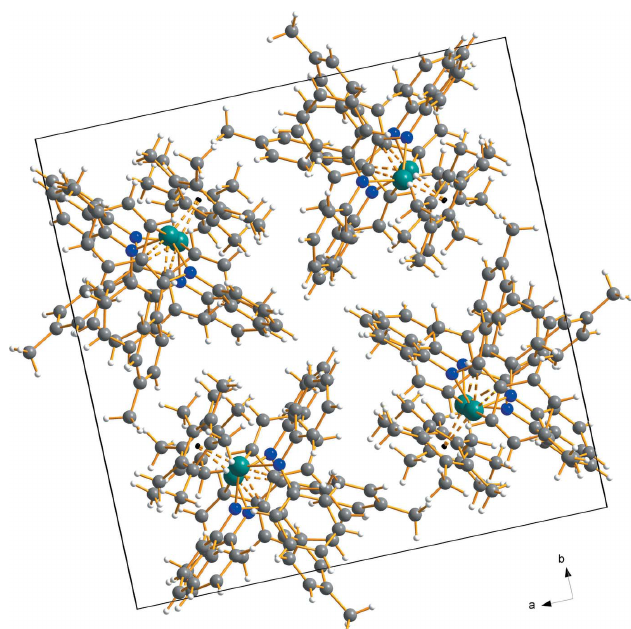
Figure 2 A view along the c axis, showing the packing of the molecules in the crystal structure of complex 1 . No significant supramolecular features can be observed. Colour code: C grey, H colourless, N blue and Ti turquoise spheres.